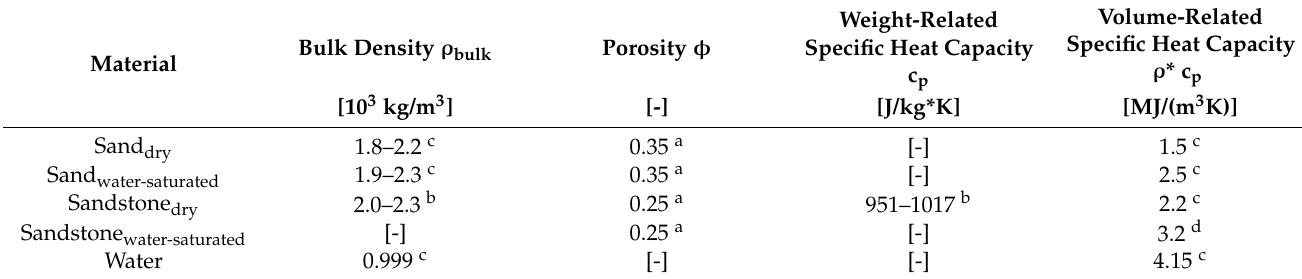
Table 1. Rock parameters, derived from literature data for modelling the